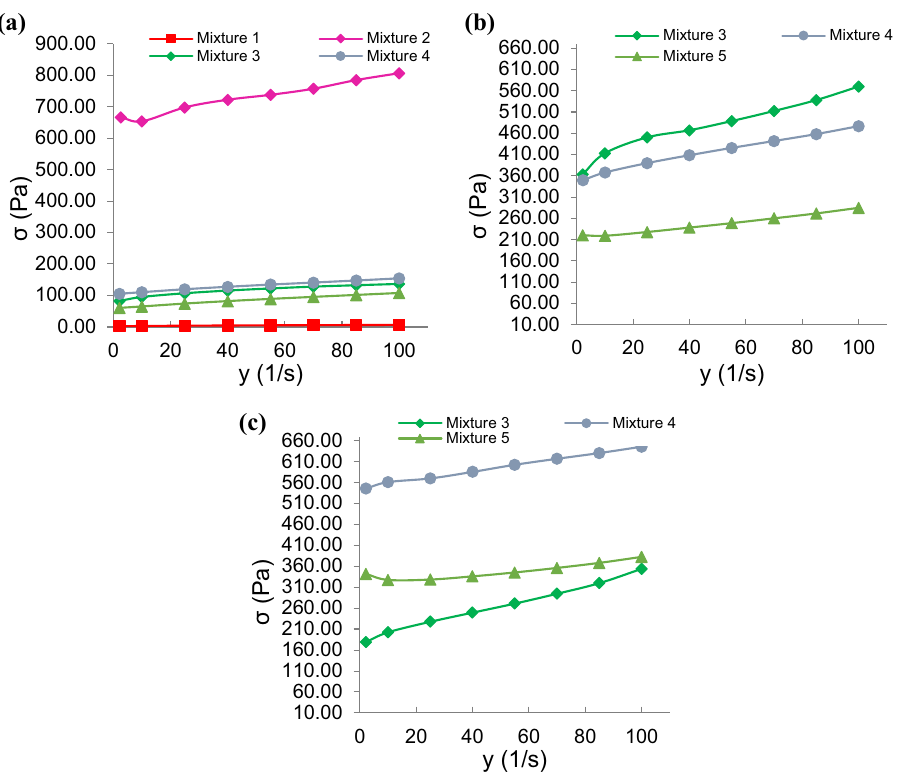
Figure 4: Shear stress vs shear rate over time. ( a ) 0 h; ( b ) 24 h; ( c ) 48 h. Mixture 1: Ref.100%C; Mixture 2: 50%C.50%PG; Mixture 3: 50% PG.0.5%HSA; Mixture 4: 50%PG.0.5%HSA.0.15%HPMC; Mixture 5: